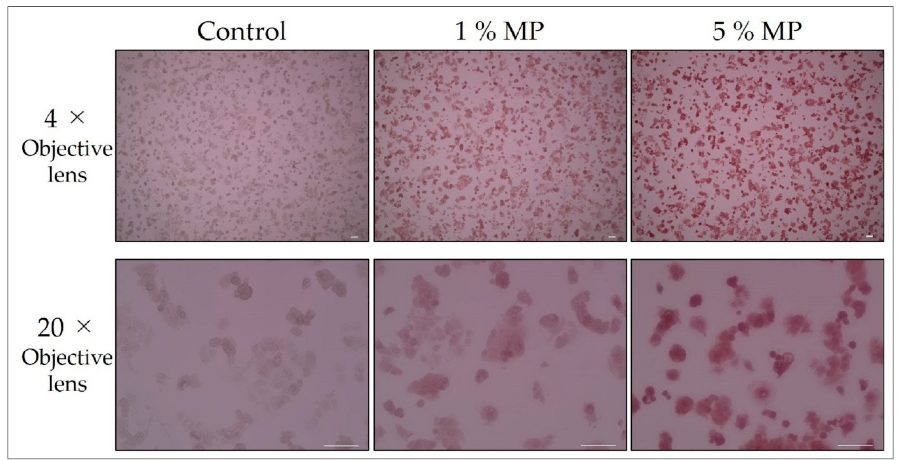
Figure 1. Magnification of observation and staining of dead cells (microwave treatment). All scale bars designate 100 μ m.